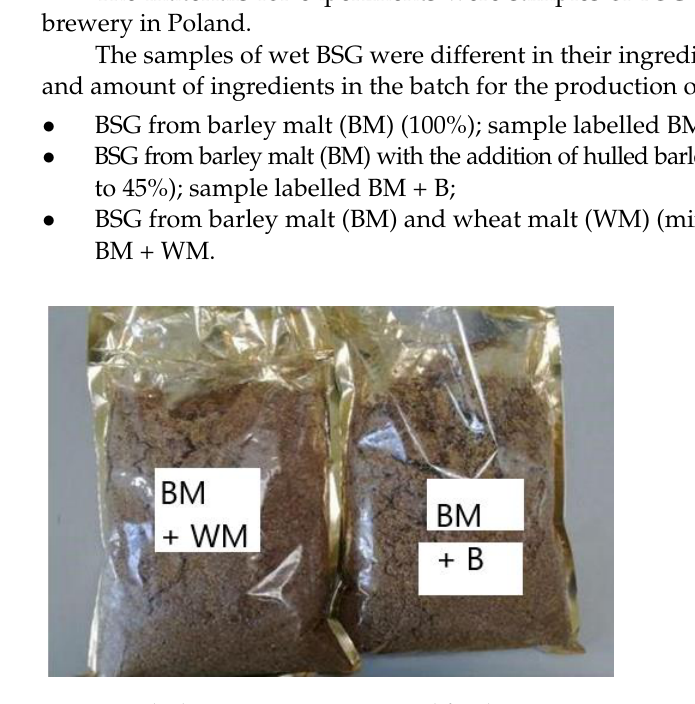
Figure 1. The brewer’s spent grain used for the experiments .